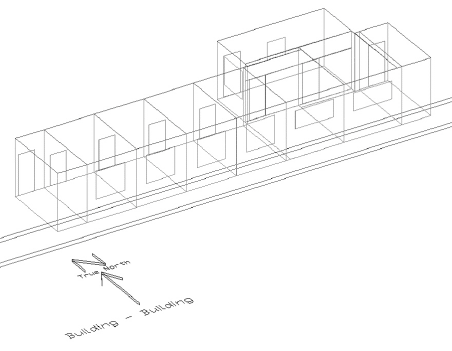
Figure 8. Simulation model of mock-up with the building performance simulation tool, EnergyPlus.